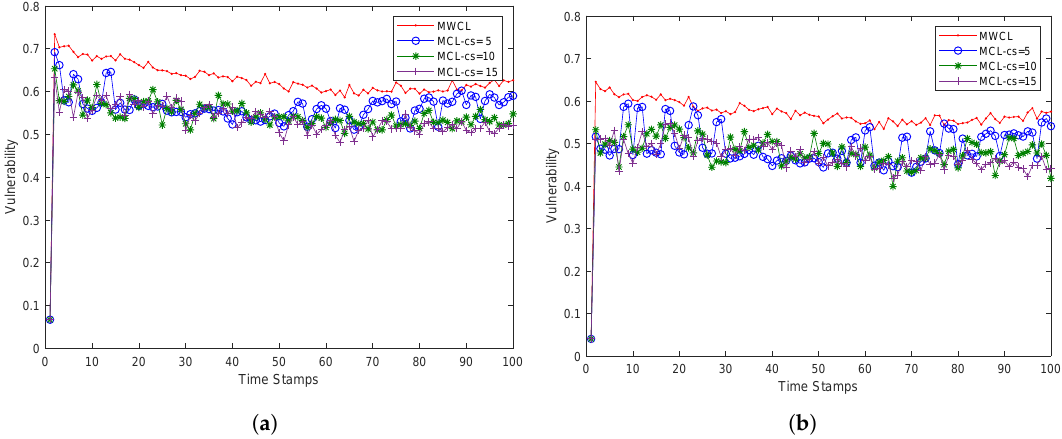
Figure 9. Clustering with ( x , y , g , v ) and k -NN in x . Figure ( a ) concerns k = 15 while ( b ) k = 30 for N = 2000 trajectories and L = 100